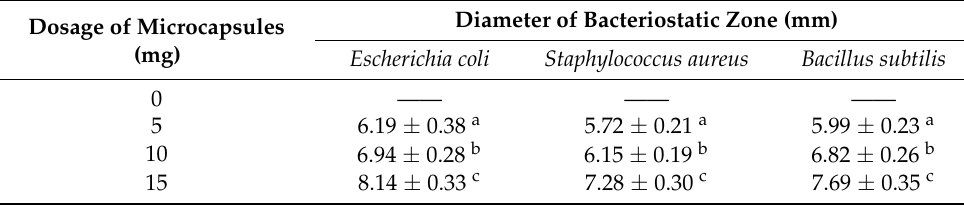
Table 3. Antibacterial test of ginger essential oil microcapsules. Diameter of Bacteriostatic Zone Dosage of Microcapsules (mg)